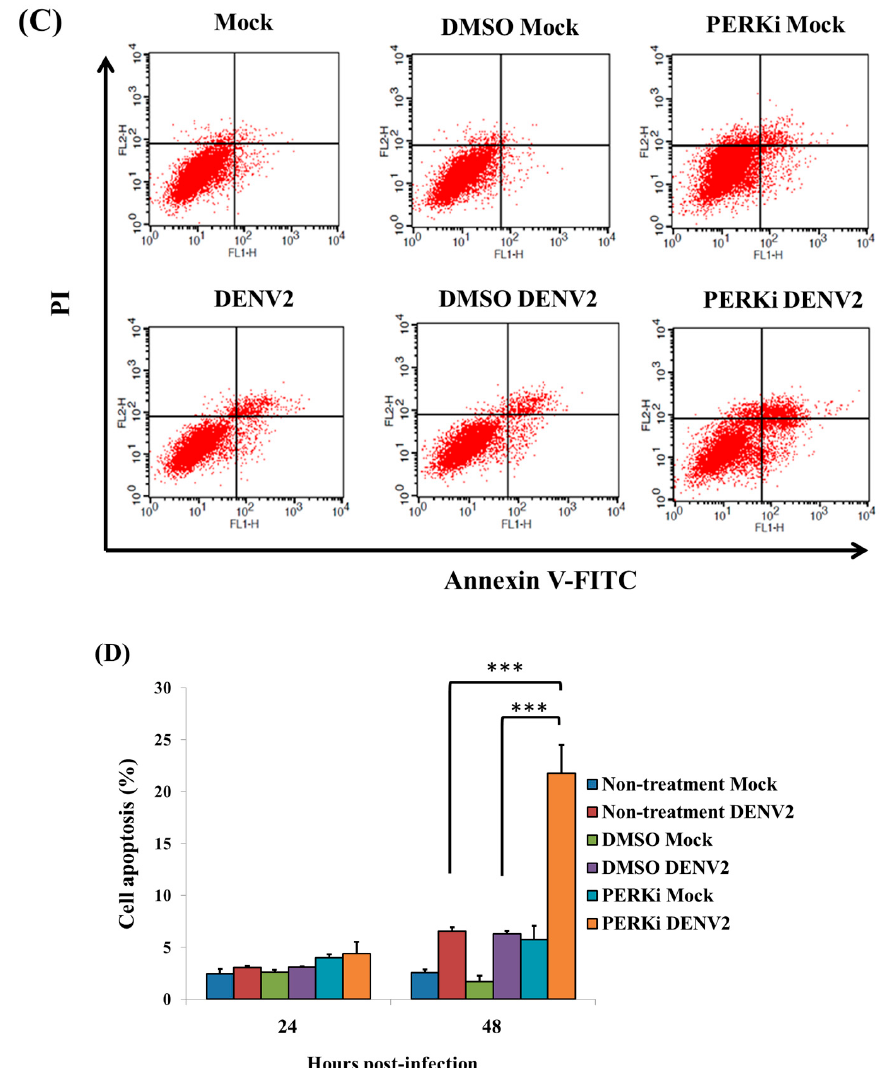
Figure 7. The involvement of the PERK signaling pathway in a reduction of cell death in C6/36 cells with dengue 2 virus (DENV2) infection. ( A ) Cell cycle progression was detected by PI staining in DENV2-infected C6/36 cells (MOI = 1) treated with a PERK inhibitor (5 µ M). The result revealed that there was a higher rate (7.01%) of the sub-G 1 phase at 48 h post-infection (hpi); ( B ) Staining of DENV2-infected cells with Annexin V-FITC/PI followed by fluorescence activated cell sorting (FACS) revealed that slight apoptosis-related cell death had occurred at 24 hpi; ( C ) Apoptosis-related cell death in cells of the same group as above had obviously increased by 48 hpi; ( D ) At 48 hpi, there was a statistically higher apoptosis-related cell death rate in the group treated with the PERK inhibitor and infected with the DENV2 compared to the other two control groups with DENV2 infection (Student’s t -test; *** p < 0.001).